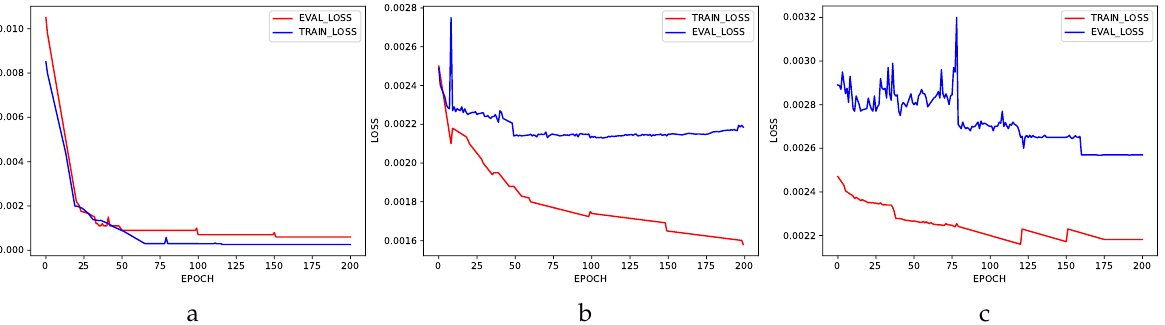
Figure 6. Convergence curves: ( a ) mildly degraded; ( b ) moderately degraded; and ( c ) severely degraded. Algorithm 1 Systematic curriculum learning algorithm for